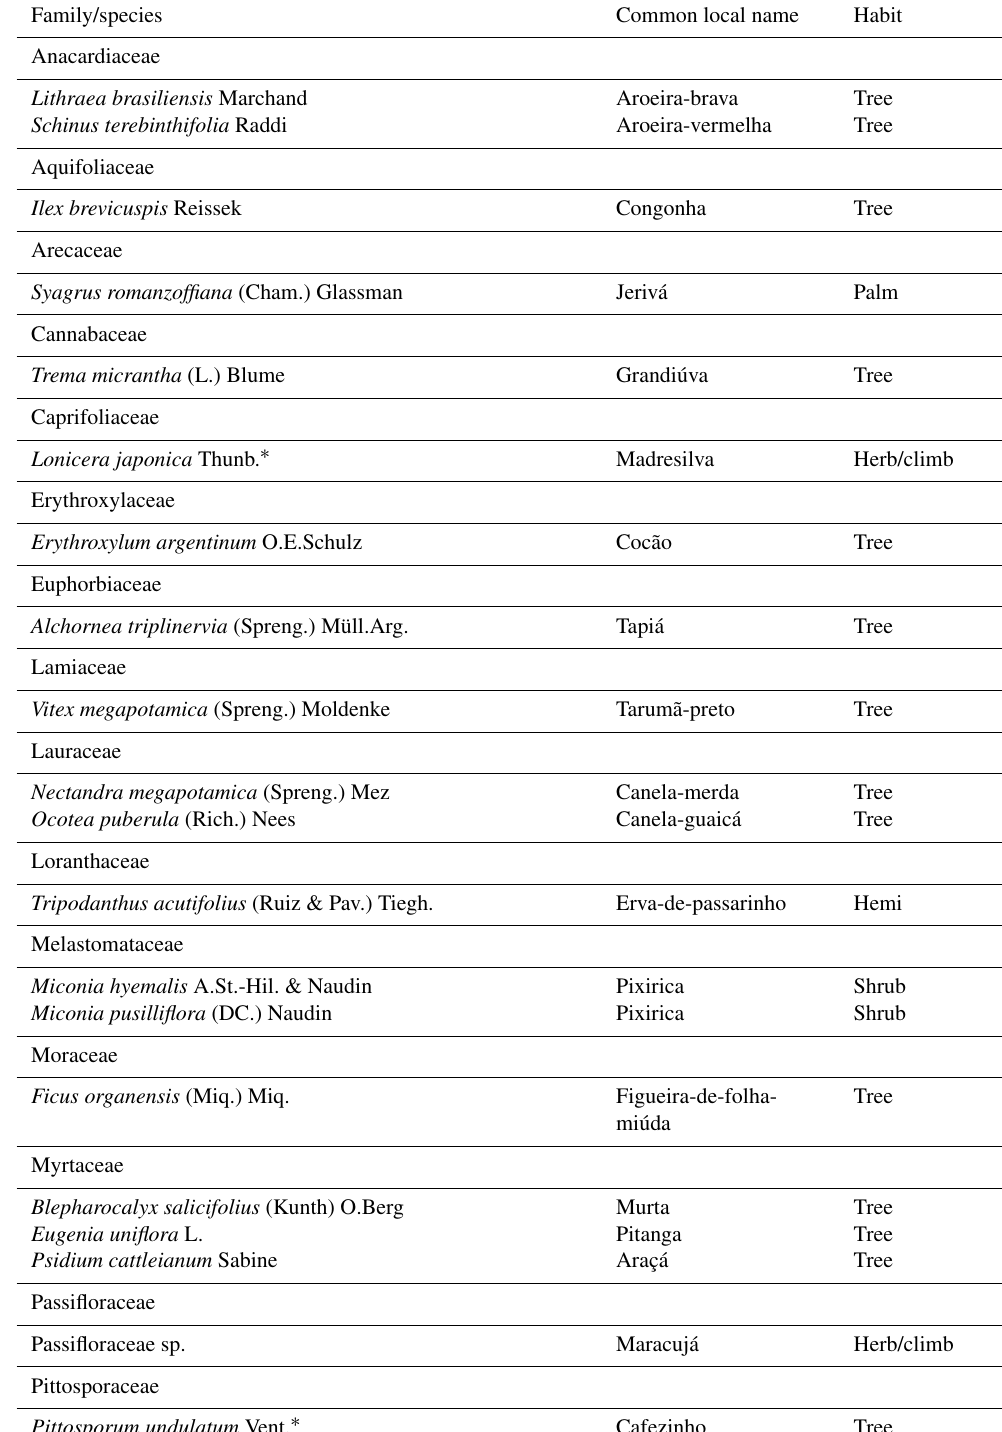
Table A1. Plant species sampled in seed rain structures (artificial perches, control seed traps, and forest seed traps) in southern Brazil. Habits: tree (Tree), palm tree (Palm), shrub (Shrub), climbing herb (Herb/climb), and hemiparasitic plant (Hemi).